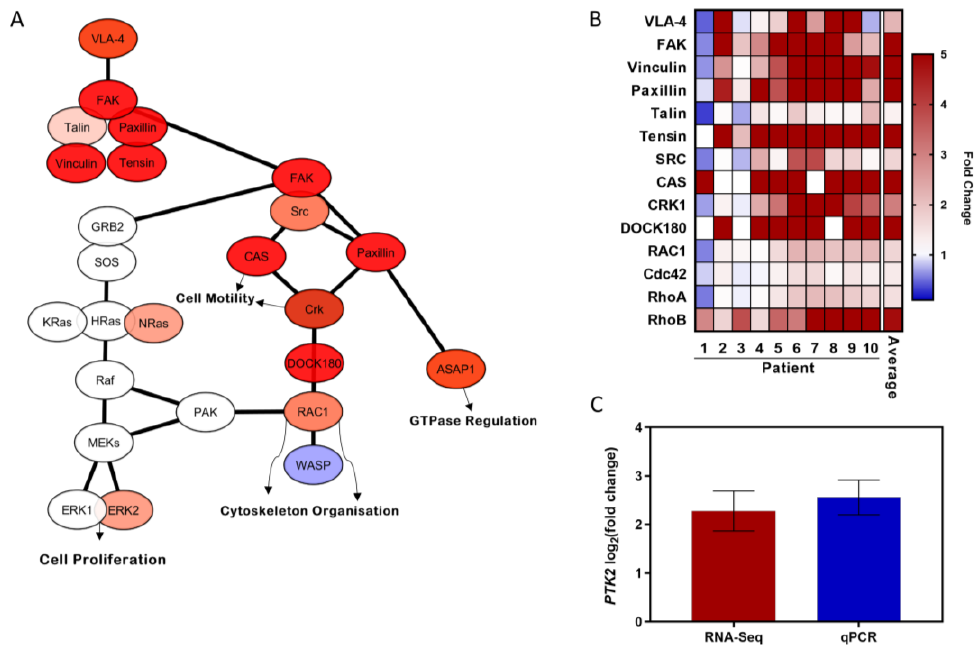
Figure 2. Migratory CLL cells harvested from our in vitro circulating system upregulate the FAK signaling pathway in comparison to CLL circulatory cells. ( A ) RNA-seq differential expression overlayed on a FAK signaling pathway Cytoscape network. ( B ) Heatmap of 14 differentially upregulated FAK signaling pathway genes from migratory CLL cells. ( C ) For validation, FAK gene expression from the RNA-seq data ( n = 10) was compared to the qPCR data ( n = 4) as assessed by a TaqMan assay.